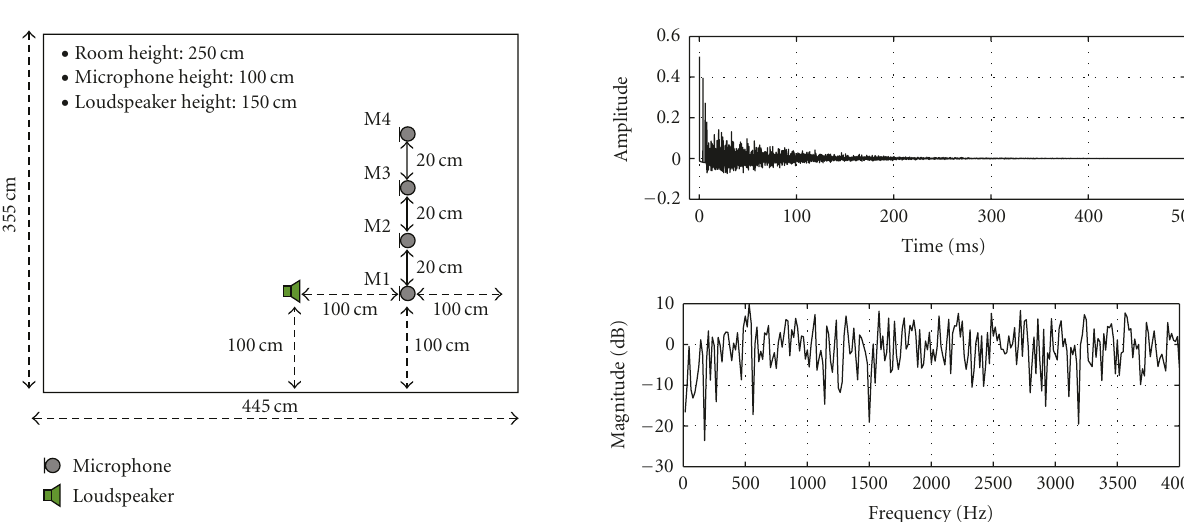
Figure 2: Source and microphone arrangement. M1, M2, M3, and M4 denote the microphones.